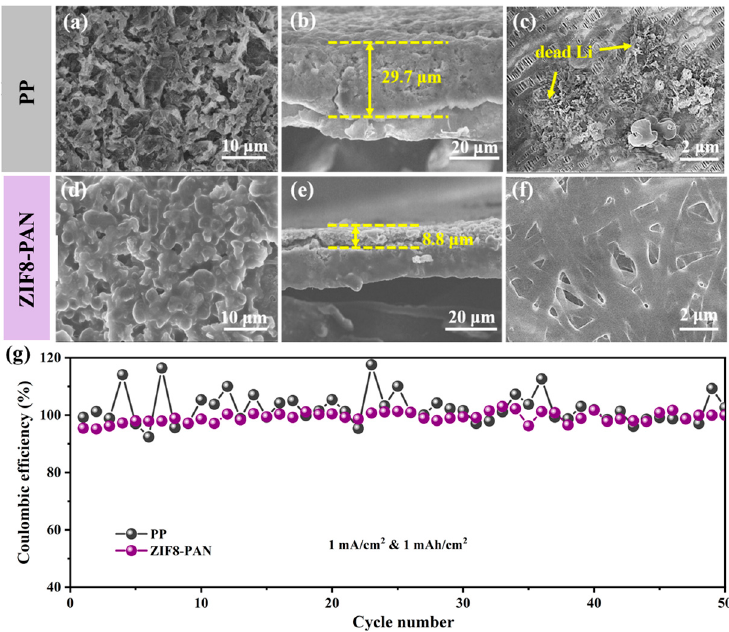
Figure 5. SEM images of ( a , d ) top-surface of Cu foil; ( b , e ) cross-section of Cu foil; ( c , f ) the surface of the separators disassembled from Li//Cu half cells with PP and ZIF8-PAN separator, respectively. ( g ) The CE comparison of Li//Cu half cells with PP and ZIF8-PAN separator for a current density of 1.0 mA/cm 2 with an area capacity of 1.0 mAh/cm 2 .